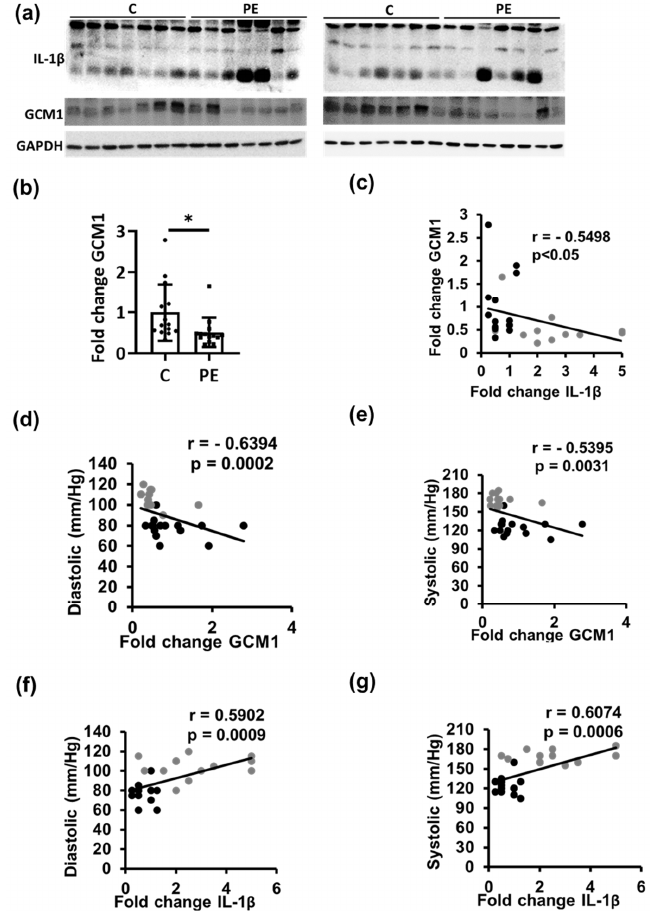
Figure 4. Trophoblast differentiation is associated with inflammasome activation in human PE pla ‐ centa. ( a – c ) Trophoblast differentiation marker GCM1 ( a ), representative immunoblots; ( c , d ), quan ‐ tification summarizing results) is reduced ( c ) in human placenta from preeclampsia (PE) and in ‐ versely correlated with inflammasome marker cleaved IL ‐ 1 β ( b ) in control (C, black dots) and PE (grey dots) patients. ( d – g ) Diastolic and systolic blood pressure are negatively correlated with troph ‐ oblast differentiation marker GCM1 and positively correlated with inflammasome marker (IL ‐ 1 β ) in control and preeclampsia patients. n = 14 placenta each group; * p < 0.05 (correlation: t ‐ test, ( c – g ): Spearman’s